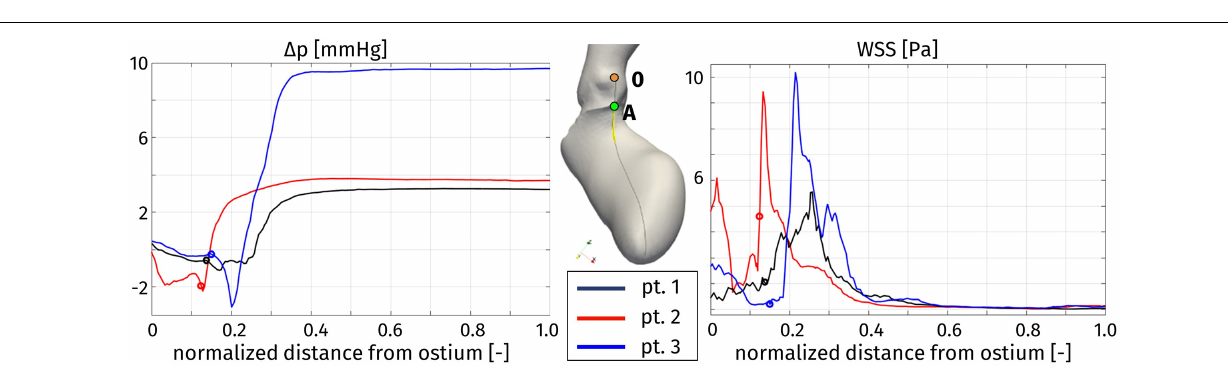
FIGURE 10 | Distribution of pressure difference with respect to the Valsalva sinuses (left) and wall shear stress (right) along a line on the septum (center), at the instant of maximum pressure gradient: Patient 1, t = 0.08 s; Patient 2, t = 0.16 s; and Patient 3, t = 0.20 s. The distance is normalized with respect to the total length of the line. For each patient, the origin of the line in the right coronary ostium is denoted by 0, while the position of the aortic annulus (point A in the center figure) is indicated by a